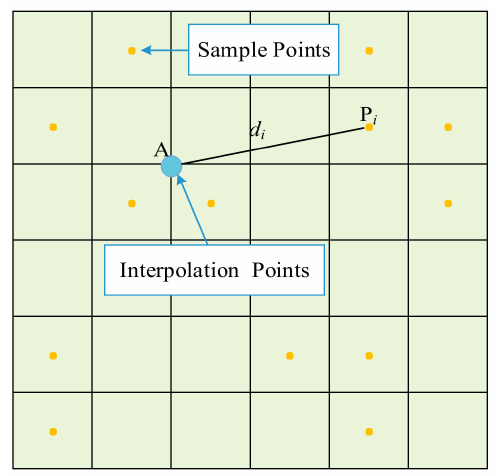
Figure 5. Schematic diagram of IDW